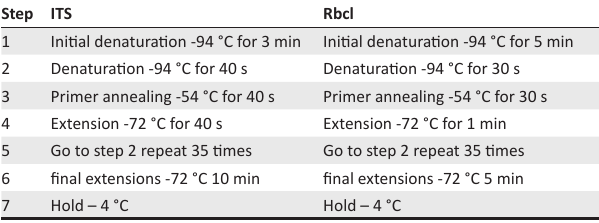
TABLE 1: Polymerase chain reaction conditions for internal transcribed spacer and ribulose-1,5-bisphosphate carboxylase gene Isoberlinia doka and Isoberlinia tomentosa .